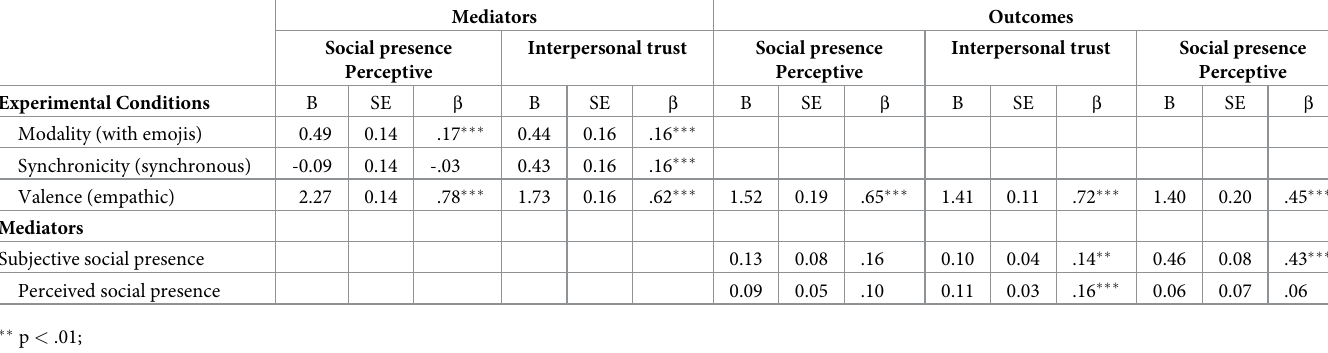
Table 2. Path coefficients and significance level of the final Structural Equation Model. Mediators Outcomes Social presence Interpersonal trust Social presence Interpersonal trust Social presence Perceptive Perceptive